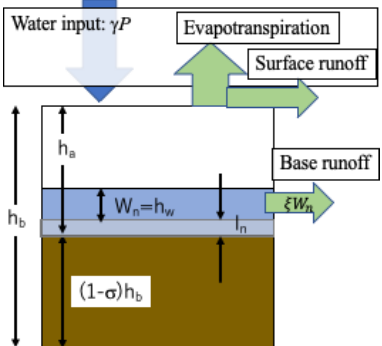
Figure 3. Schematic of hydrological processes of the subsurface box. It is a bucket-type reservoir of capacity h b (m), consisting of liquid water ( W n = h w ) within the pore space ( h a = σh b ) and soil ( ( 1 − σ)h b ). Quantity of ice forming or melting at a time step is limited by current liquid or solid water amount, respectively (Eq. 9); total amount of ice ( I n ) can supersede the capacity h b to represent massive ground